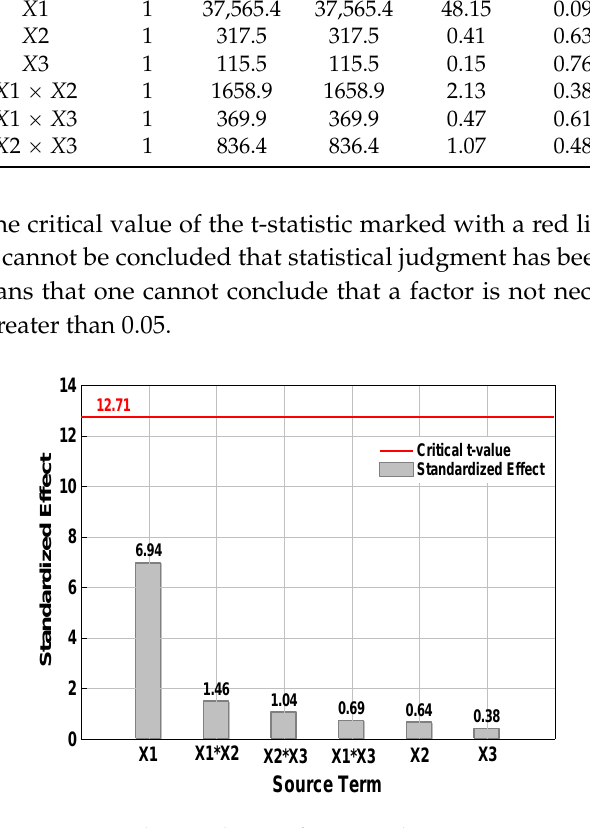
Figure 6. Pareto chart with main factors and two-way interactions.